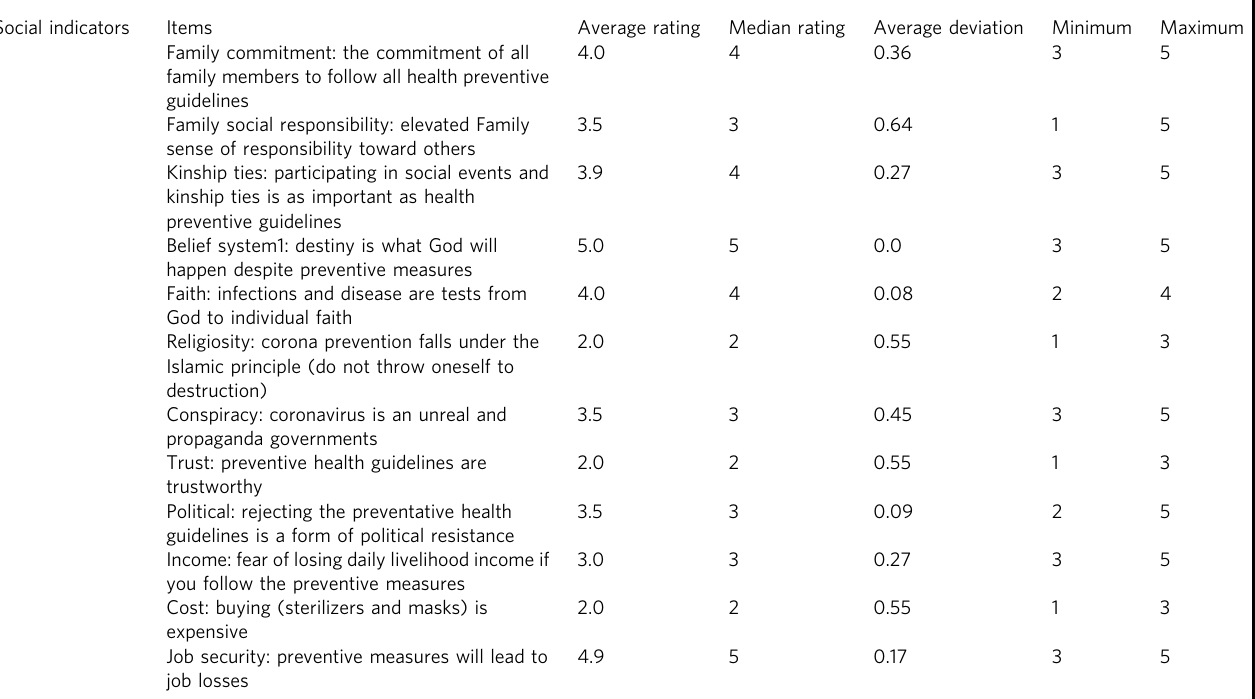
Table 2 The social indicators of individual COVID 19 preventive behavior. Social